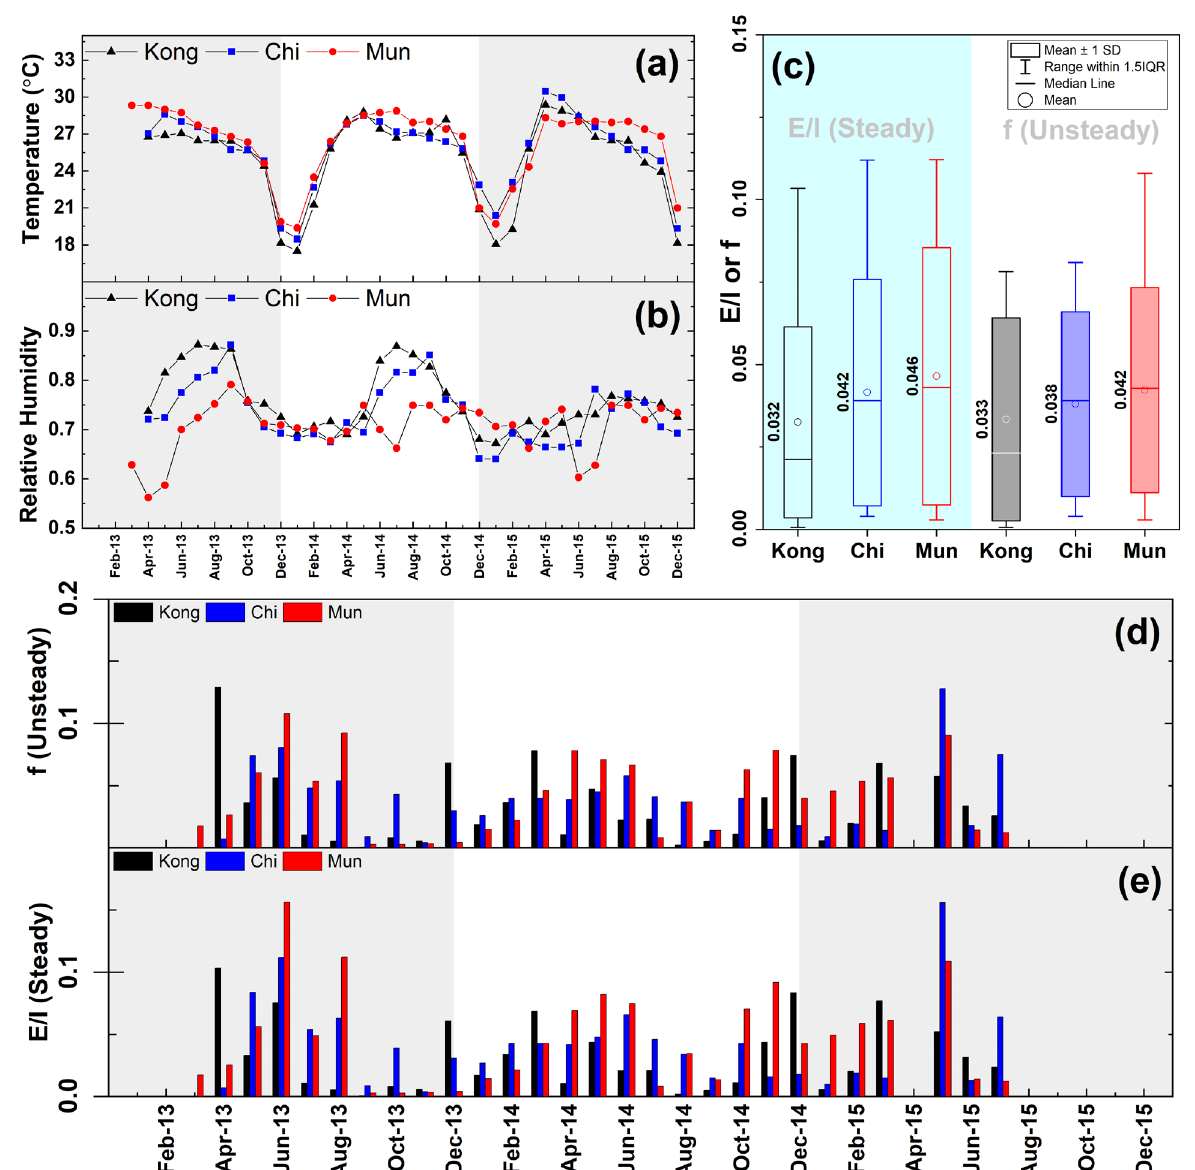
Figure 5. ( a ) Observed monthly air temperature ( ◦ C). ( b ) Observed monthly relative humidity (%). ( c ) Mean estimated E/I ratio and f values under steady and unsteady state conditions. ( d ) Estimated f values. ( e ) Estimated E/I ratios.